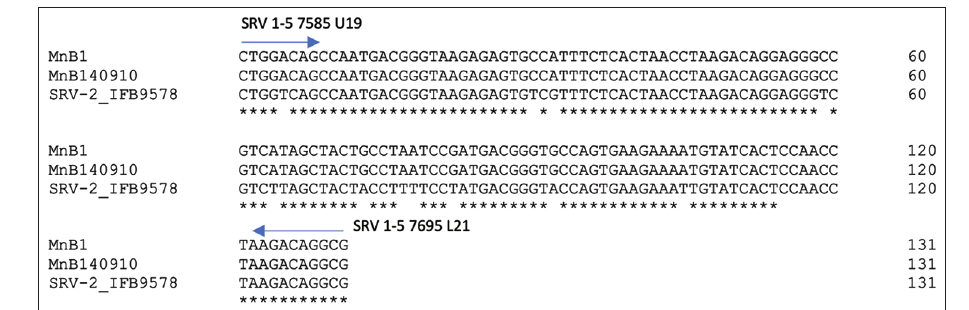
Figure-5: Alignment of novel simian endogenous retroviruses (Mn B1 and Mn B140910) and exogenous simian retroviruses (SRV) (SRV-2 IFB9578) at nucleotide positions 7585–7695 and variations (same nucleotides marked with*). The primary positions of SRV1-5 7585 U19 and SRV1-5 7695 L21 are marked with